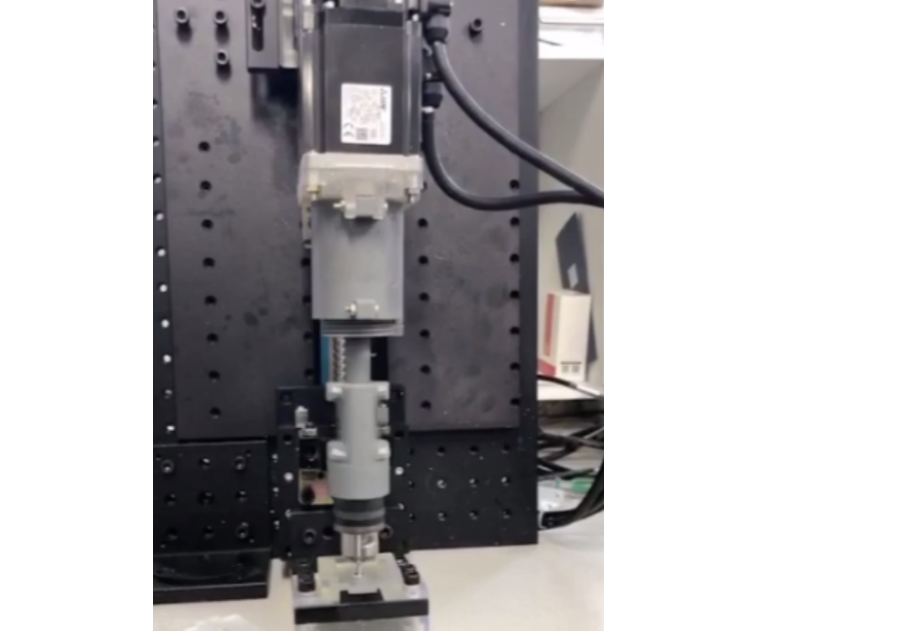
Figure 1. A photo of the entire system. The proposed design consists of an approaching component and an ID component.